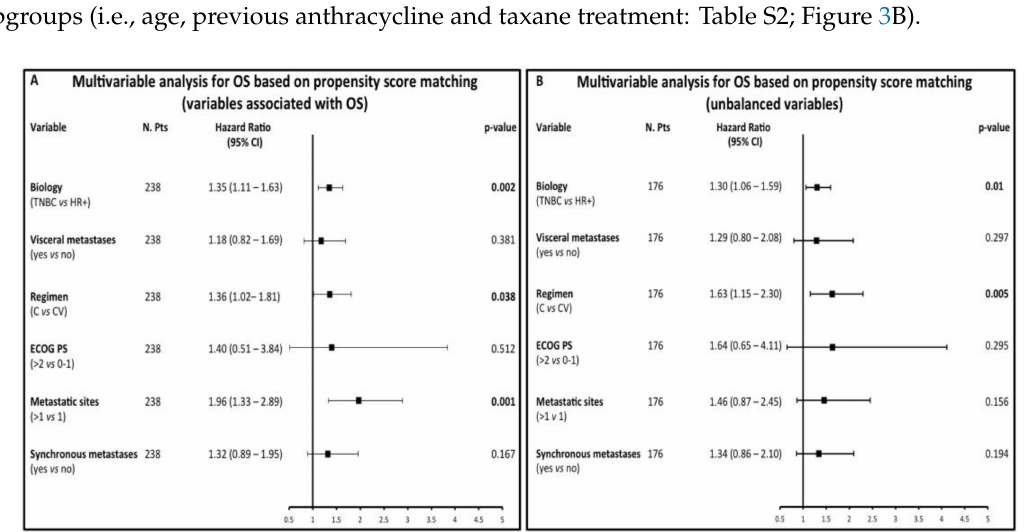
Figure 3. ( A , B ): multivariable analysis investigating the independent association between the type of treatment received (CV vs C) and other meaningful variables in patient populations matched on the basis of their propensity scores according to clinical / tumor characteristics independently associated with OS ( A ) or that are imbalanced in the CV and C treatment cohorts ( B